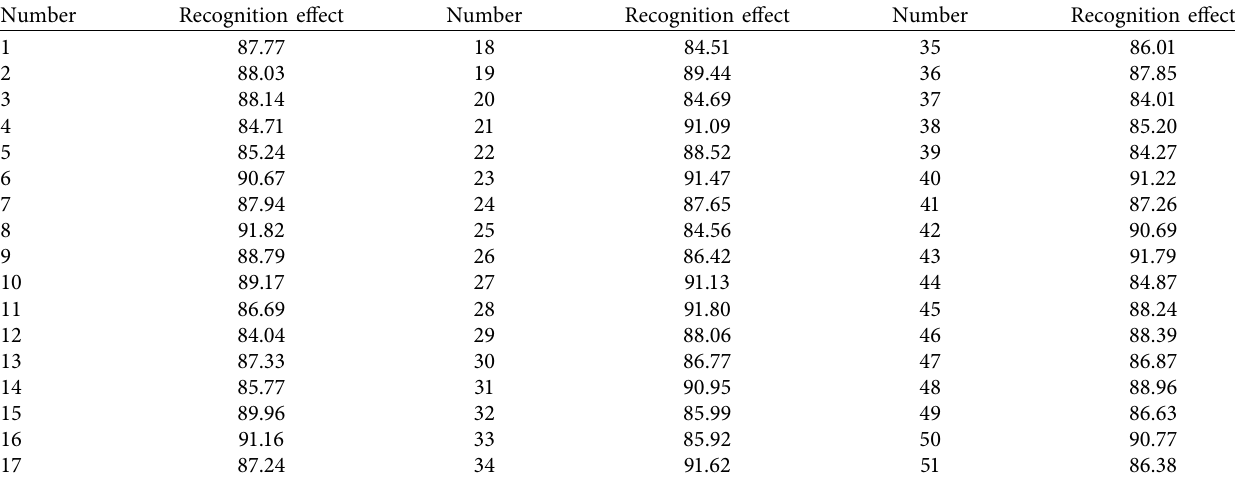
Table 1: The evaluation effect of the system on the students’ learning status in foreign language